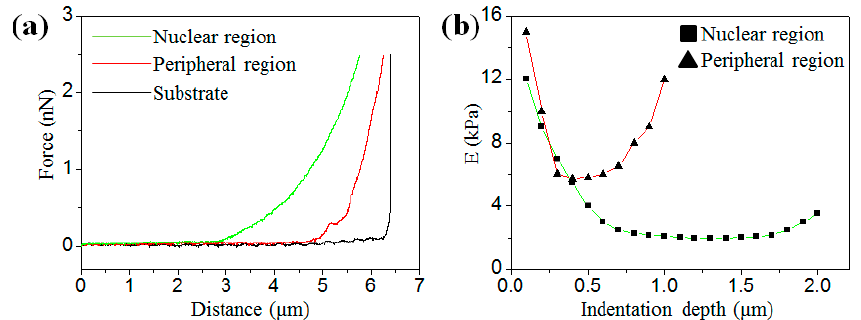
Figure 1. ( a ) Three representative force–distance curves obtained from the substrate, the nuclear and peripheral regions of an osteosarcoma cell, respectively; ( b ) the relationship between the elastic modulus and the indentation depth at the nuclear and peripheral regions, respectively.